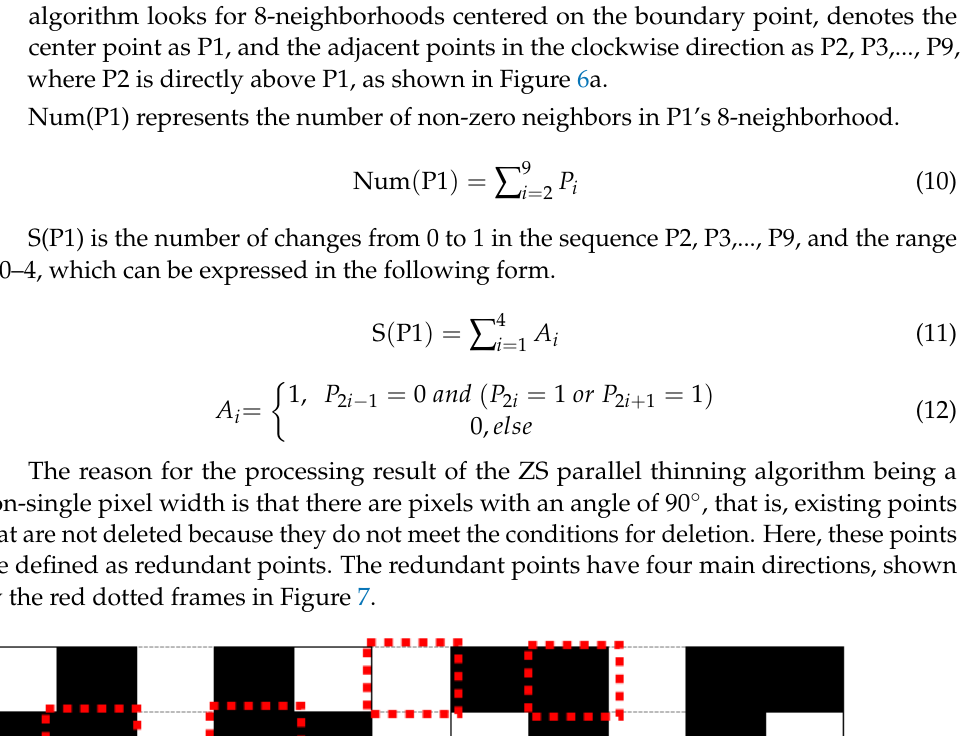
Figure 6. ( a ) 3 × 3 neighborhood; ( b ) 8-neighborhood; ( c ) 4-neighborhood; ( d ) D-neighborhood.